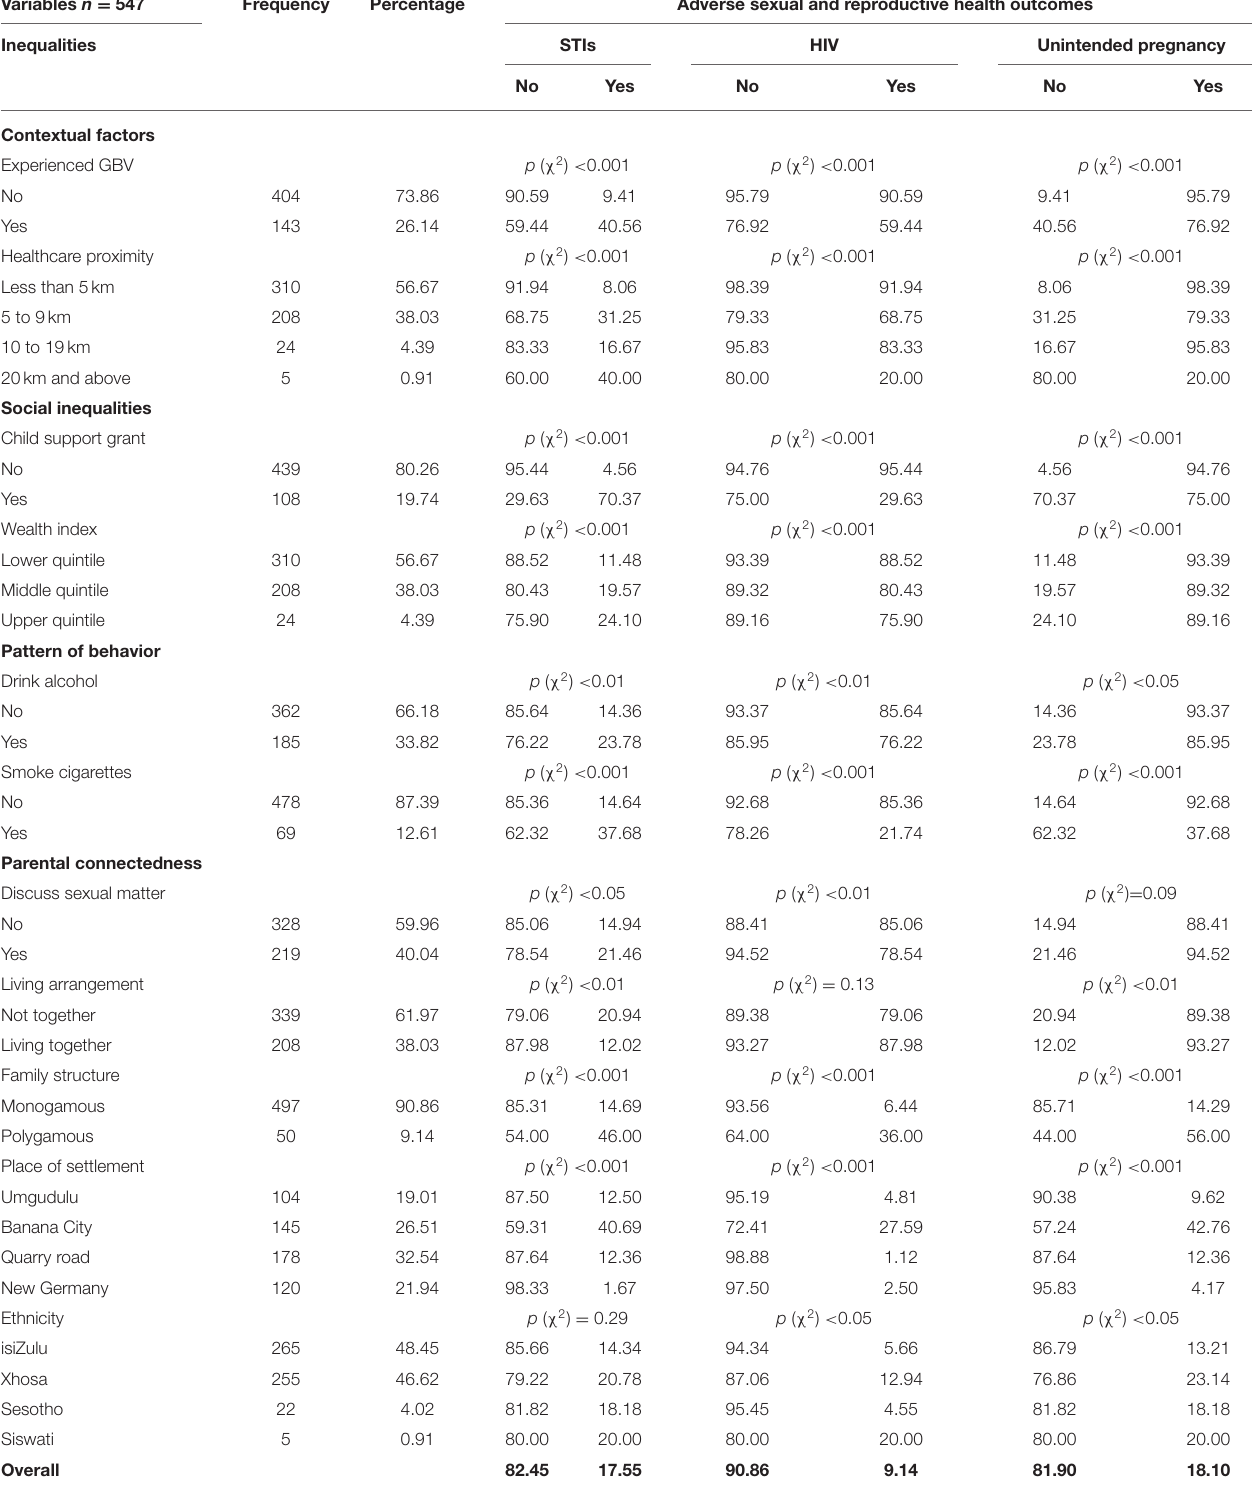
TABLE 1 | Distribution of selected inequalities and adverse sexual and reproductive health outcomes of young women in Durban informal settlements. Variables n = 547 Frequency Percentage Adverse sexual and reproductive health